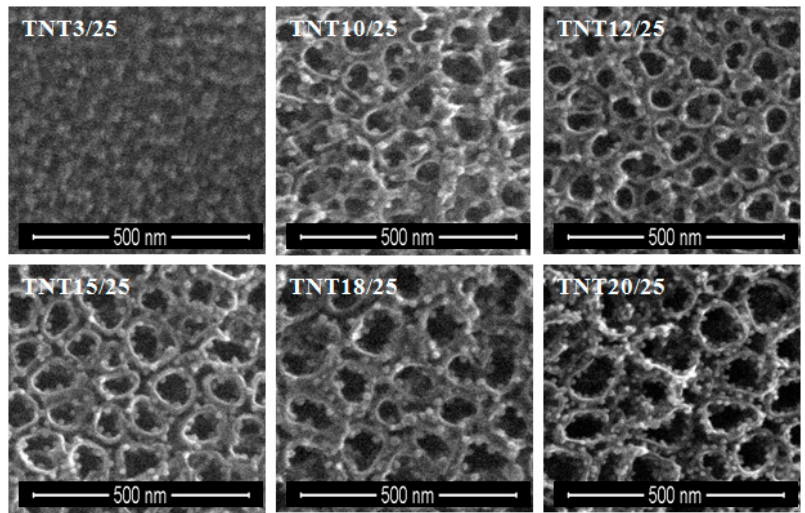
Figure 3. SEM images of TNT/Ag nanocomposite samples consisting of TNT layers prepared at 3, 10, 12, 15, 18, and 20 V, enriched with silver grains during 25 ALD cycles.